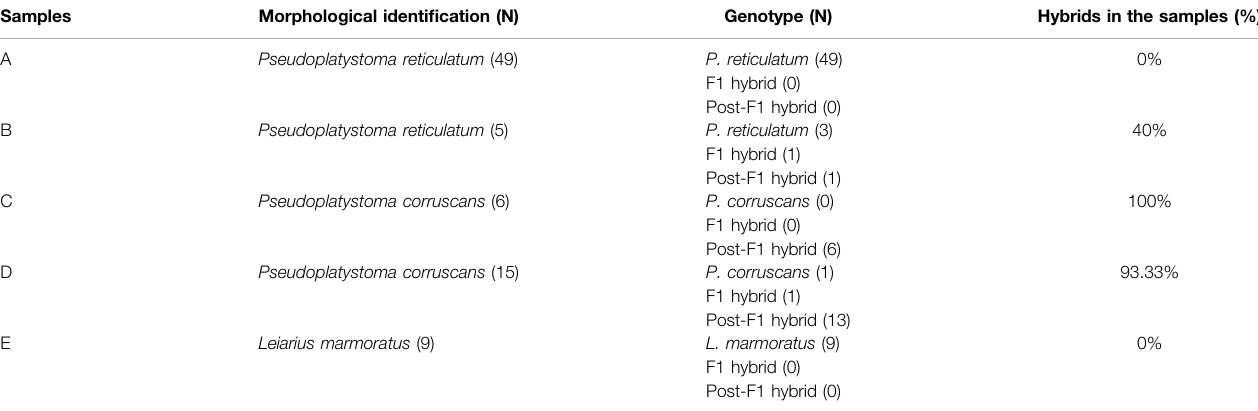
TABLE 2 | Genetic diagnosis of cat fi sh species from different research center acquired from private fi sh farms. N: number of individuals sampled; F1 hybrid: fi rst generation interspeci fi c hybrid; Post-F1 hybrid: advanced interspeci fi c hybrid. Samples